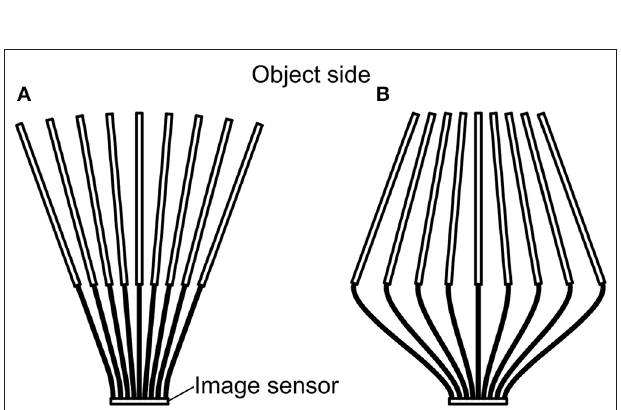
FIGURE 13 | (A) The original arrangement in the presented prototypes where the tubes diverge, with the tubes directed to the object side at the top. For clarity, the grids are not shown. (B) A converging arrangement for potential use in a microscope. In this mode the angle β is negative.